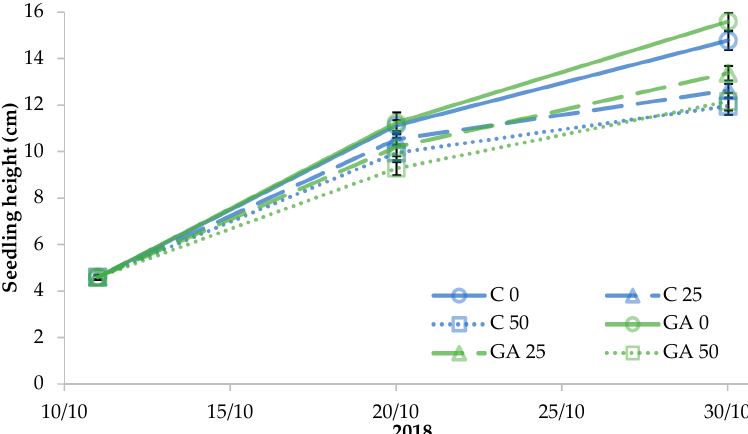
Figure 2. Effect of the seedling treatments (C, untreated control, GA, gibberellic acid spray 10 − 5 M) and salt stress (0, 25, and 50 mM NaCl) on tomato seedling growth (the least significant difference (LSD) value at p < 0.05 for 20/10 = 0.37 and for 30/10 = 0.73).